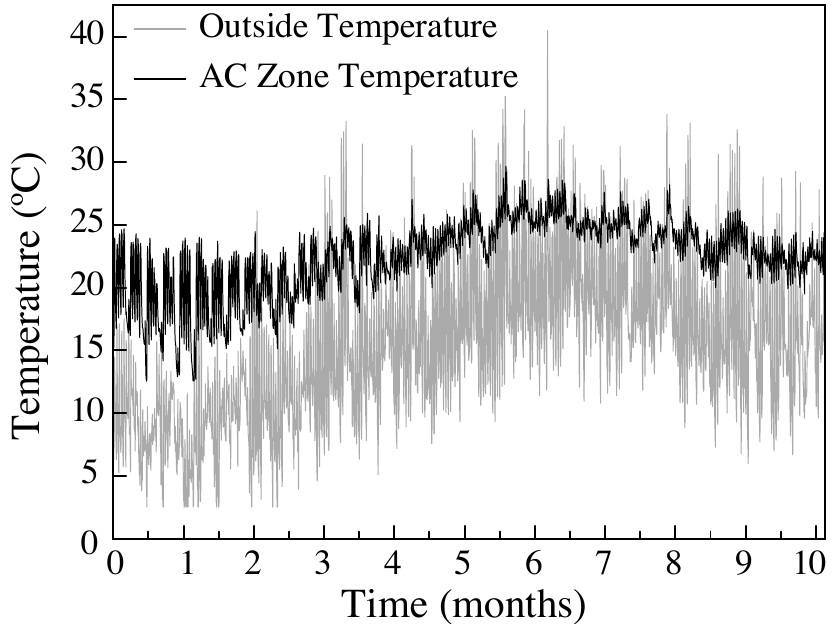
Figure 7. Internal and external temperatures measured by the web platform Equs. In the case of the outside temperature, we observe that the cold and hot temperatures are between 2 ◦ C and 41 ◦ C, approximately. The mean temperature was 15.49 ◦